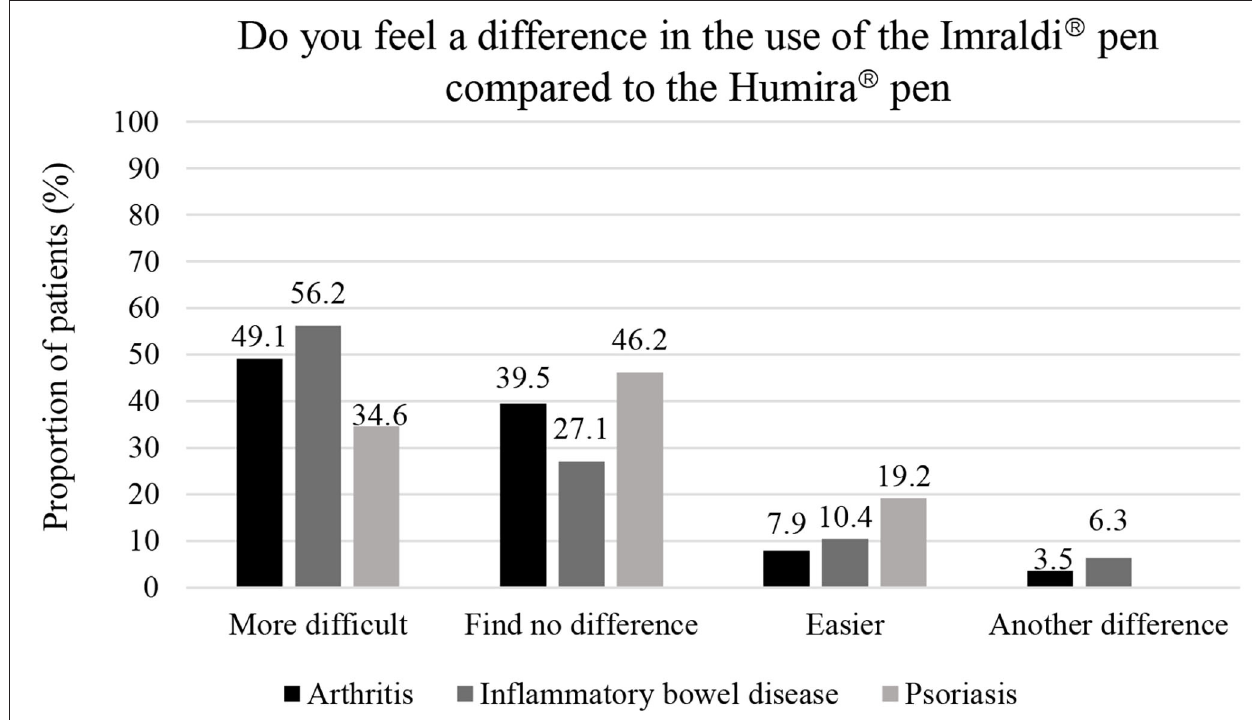
FIGURE 2 | Patients’ comparison of the use of Humira ® and Imraldi ® pens.